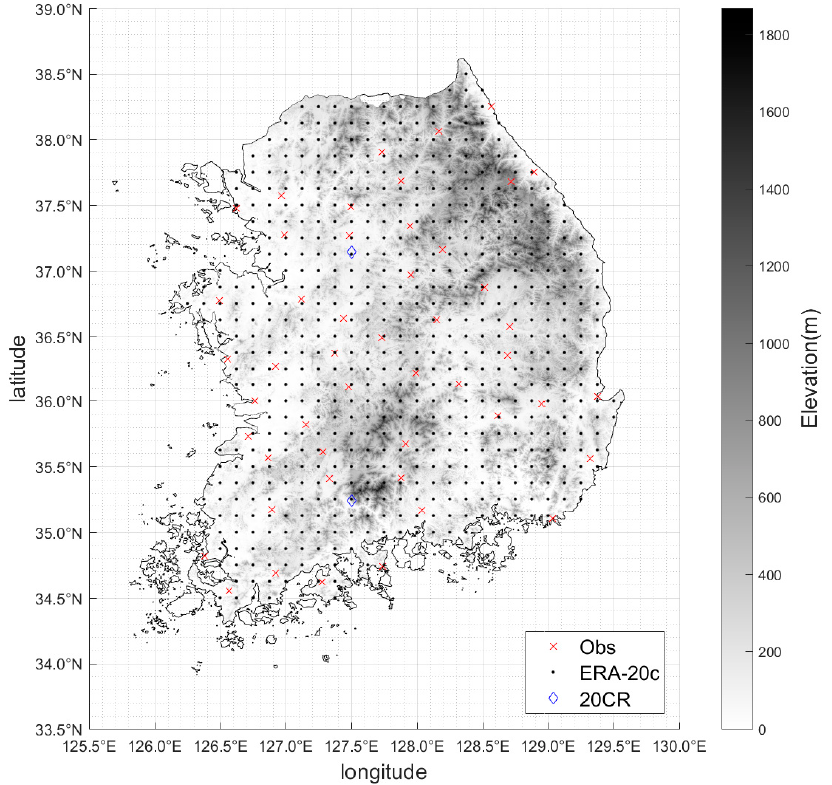
Figure 1. A map showing the study area, local gauging stations, grid points of ERA ‐ 20c and 20CR. The grey shading on the map indicates elevations.